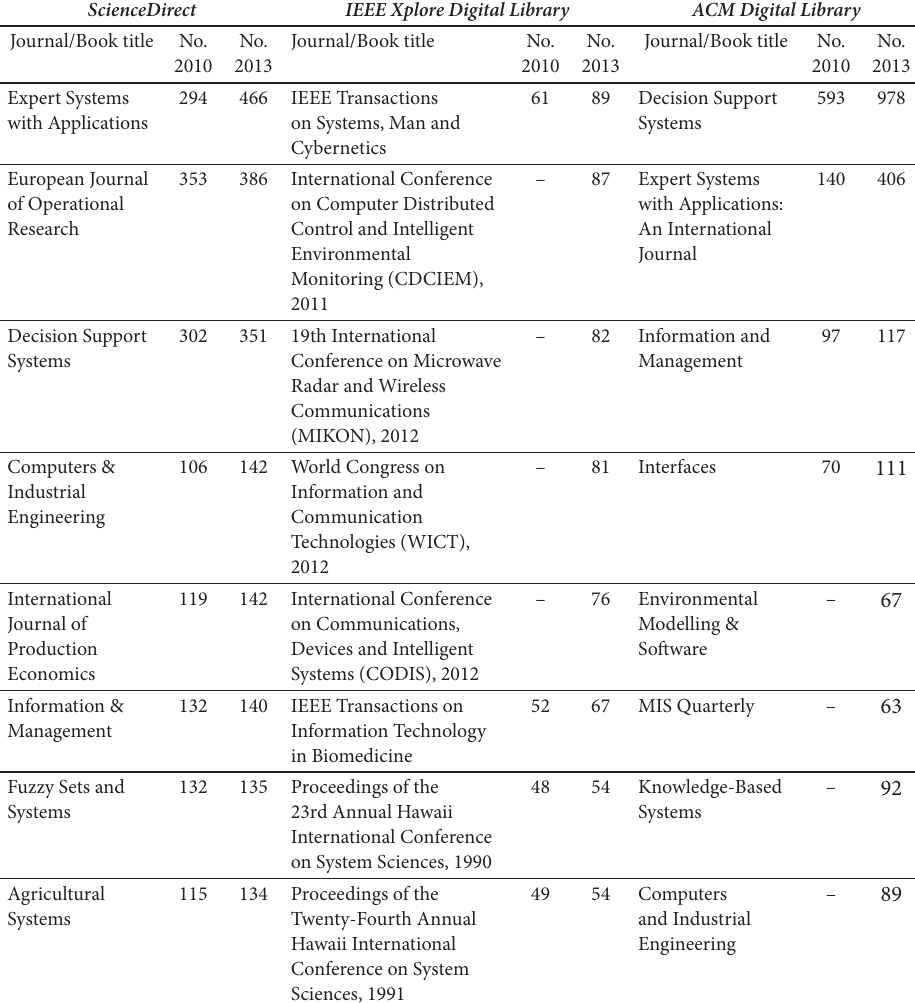
Table 3. The publications which include the highest number of DSS